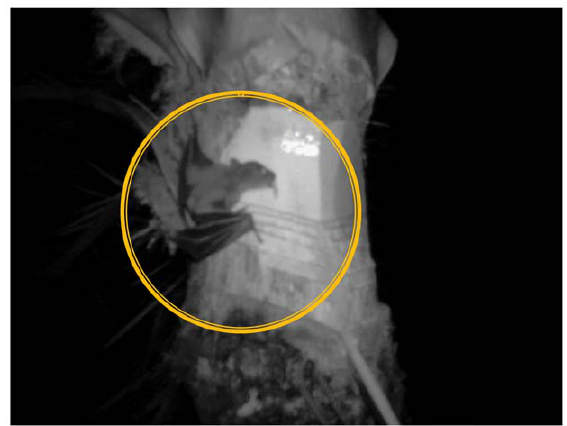
Figure 1. A picture taken by infrared night observation showing a small fruit bat (in circle) licking sap from the shaved surface of a date palm tree without any intervention during the winter of